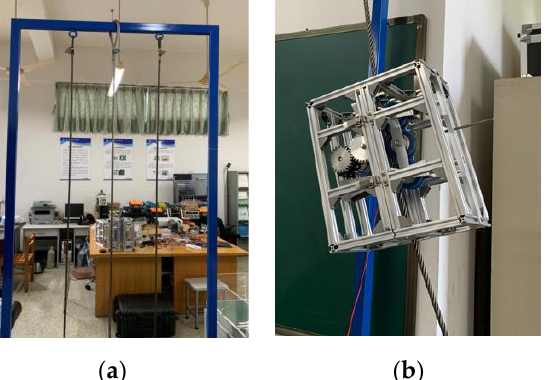
Figure 11. Experimental verification of the robot. ( a ) The experimental gantry, and ( b ) the climbing robot fixed on the gantry.